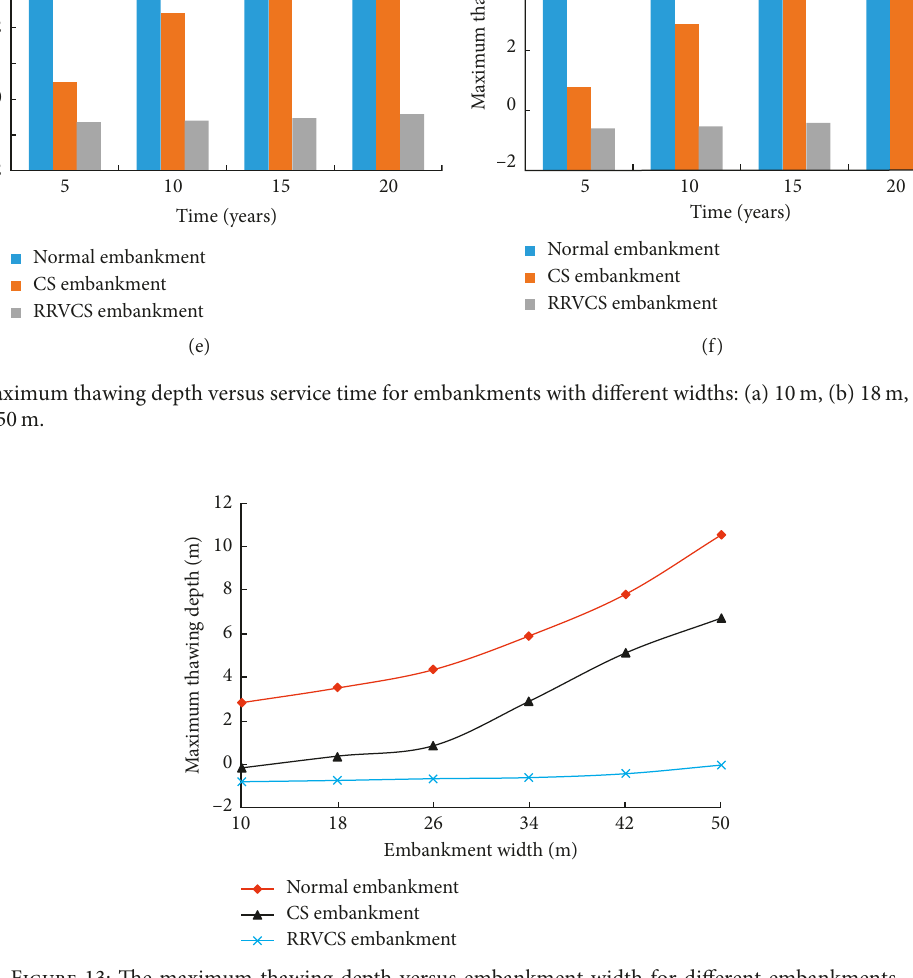
Figure 13: The maximum thawing depth versus embankment width for different embankments.